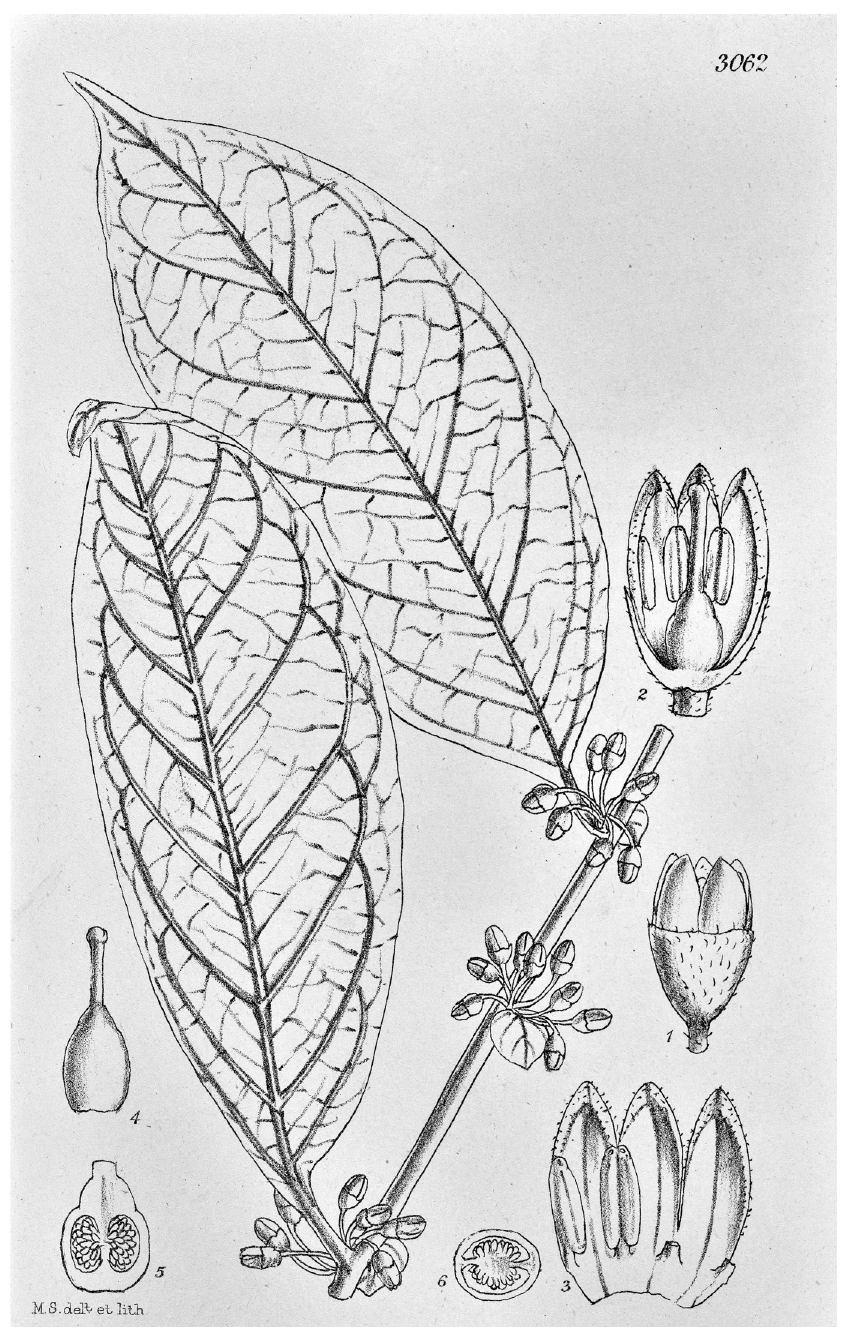
Figure 40. Lycianthes peranomala (Wernhamam ex Ridl.) A.R.Bean. Reproduced from Ridley (1922: pl. 3062, as S. peranomalum Wernham ex Ridl.). Courtesy of permission of NHM Library and Archives, reproduced with